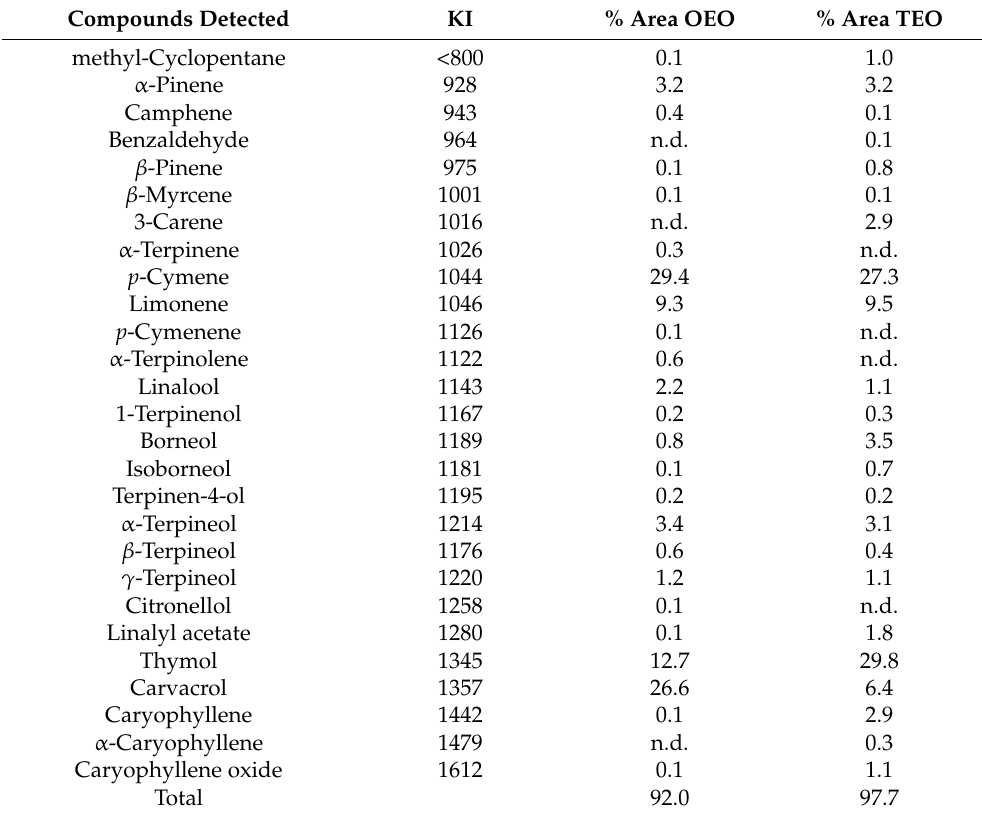
Table 3. Chemical profile of the two essential oils used, oregano (OEO) and thyme (TEO). Compounds